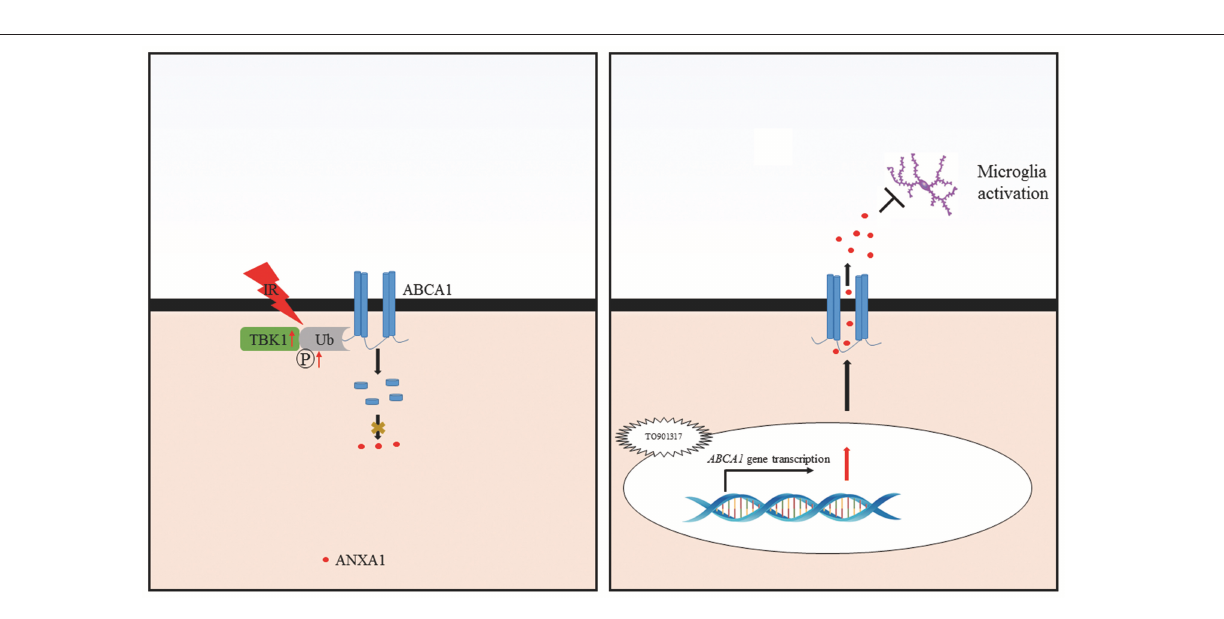
FIGURE 8 | Schematic representation of the cellular events influencing RGC apoptosis in ischemic injury. Ischemia-reperfusion injury induces an increase in TBK1 expression, which promotes ABCA1 ubiquitination and degradation, thus decreasing ANXA1 membrane transport ( Left ). TO901317 administration during ischemia-reperfusion increases the expression of ABCA1. This maintains ANXA1 membrane translocation and secretion, which inhibits microglia activation ( Right